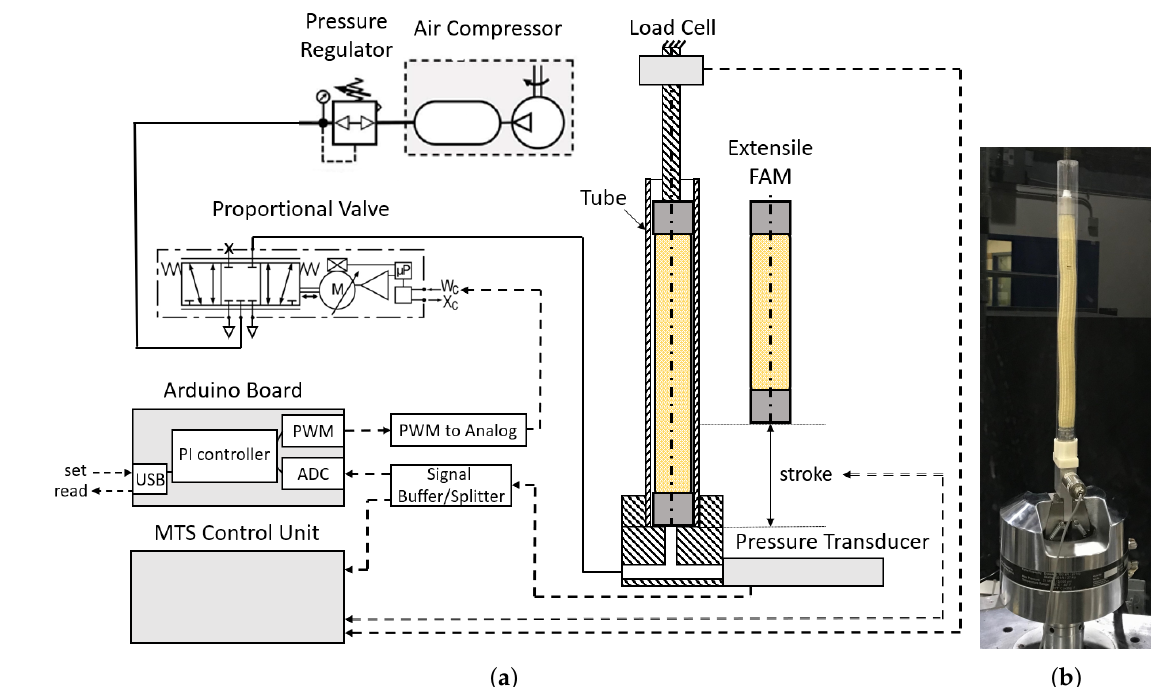
Figure 5. ( a ) Test setup schematic. Dashed lines represent electric signals. Solid lines represent pneumatic connections. Pressurized air is supplied by the air compressor and then regulated to 827.4kPa (120psi) by the pressure regulator. The proportional valve directs and tunes the air flow in or out of the FAM. FAM inflation pressure is read by the pressure transducer and split to be recorded by both the MTS control unit and the Arduino board. The Arduino board runs a proportional-integral (PI) controller that is fed the error between user-set pressure value and the FAM’s pressure. The PI controller sets the control signal for the proportional valve, which in turn increases or decreases the pressure with varying air flow. The EFAM generates compression on the load cell, which depends on both EFAM internal pressure and displacement (or stroke) of the MTS machine. Time, compressive force, pressure, and displacement are recorded by the MTS control unit to form a dataset for a given experiment. ( b ) The extensile fluidic artificial muscle (EFAM) being